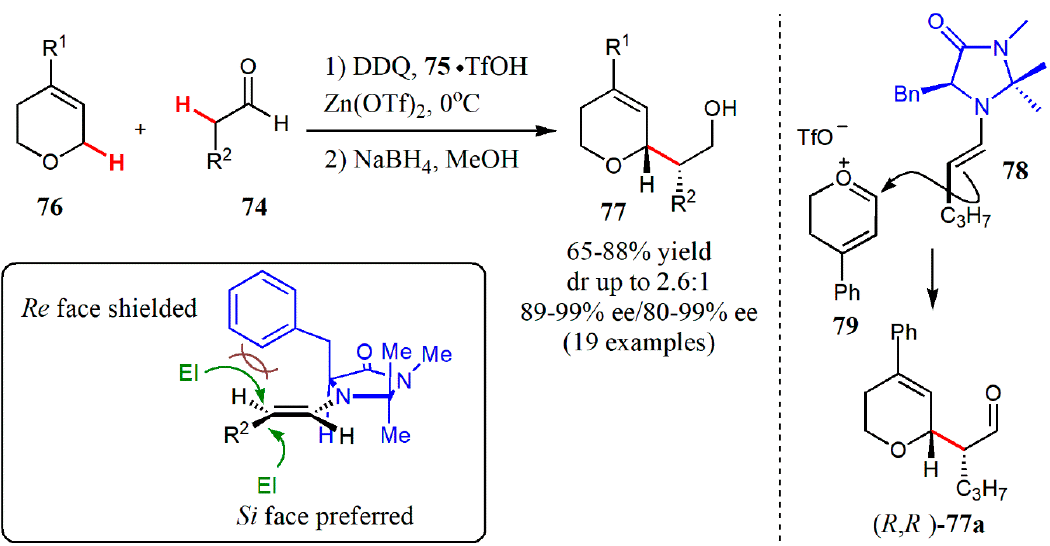
Figure 23. Enantioselective CDC of 3,6-dihydro-2 H -pyrans with aldehydes.